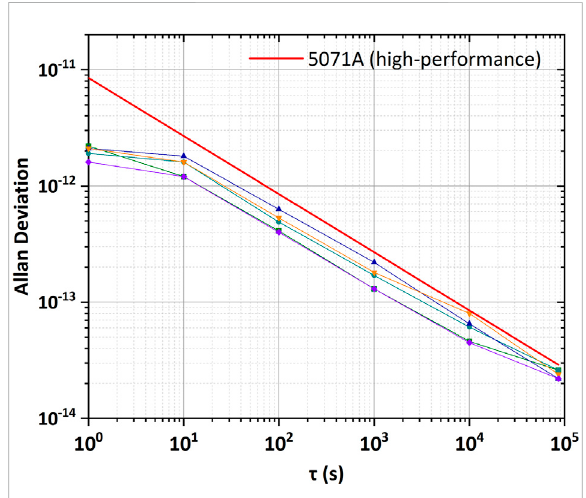
FIGURE 2 Frequency stability test result of fi ve OMCC in comparison with the high-performance version of